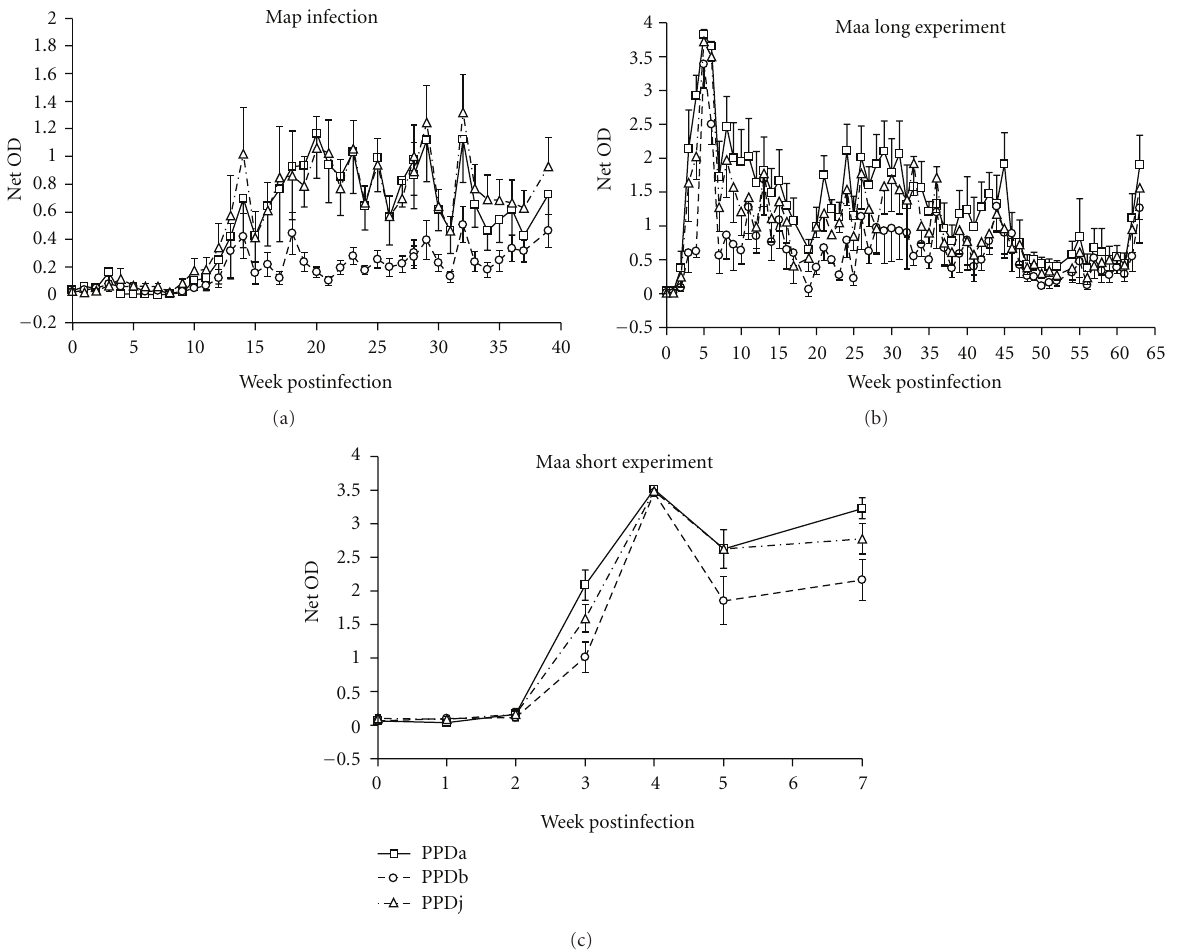
Figure 1: (a) Mean IFN- γ net OD values from whole blood stimulated with PPDa, PPDb, and PPDj tuberculins from 12 Map-exposed calves over 39 weeks. For clarity, only one side of the standard error of measurement bar is shown for PPDa and PPDj data points. (b) Mean IFN- γ net OD values from whole blood stimulated with PPDa, PPDb, and PPDj tuberculins from 6 Maa-exposed calves over 64 weeks. (c) Mean IFN- γ net OD values from whole blood stimulated with PPDa, PPDb, and PPDj tuberculins from 12 Maa-exposed calves over 7 weeks.